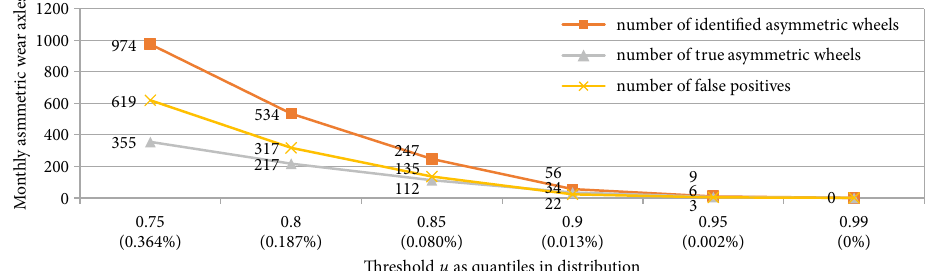
Figure 4. Identification results with different threshold u (the false alarm rates are indicated in the labels of x -axis)